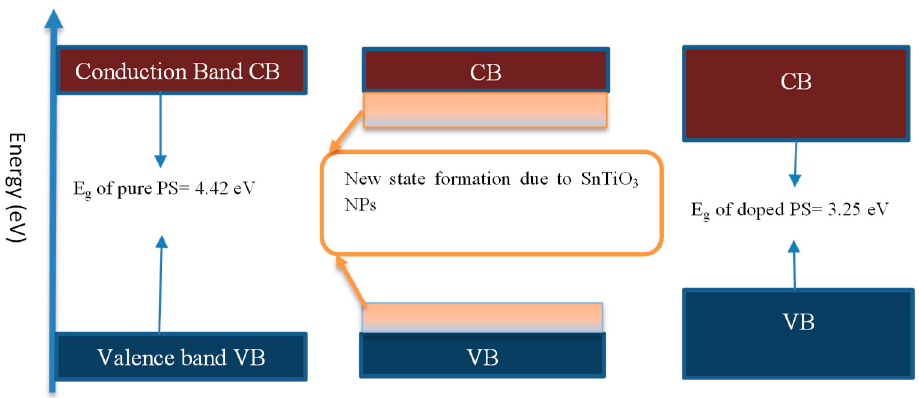
Figure 8. Nanofiller e ff ect on the band gap reduction.